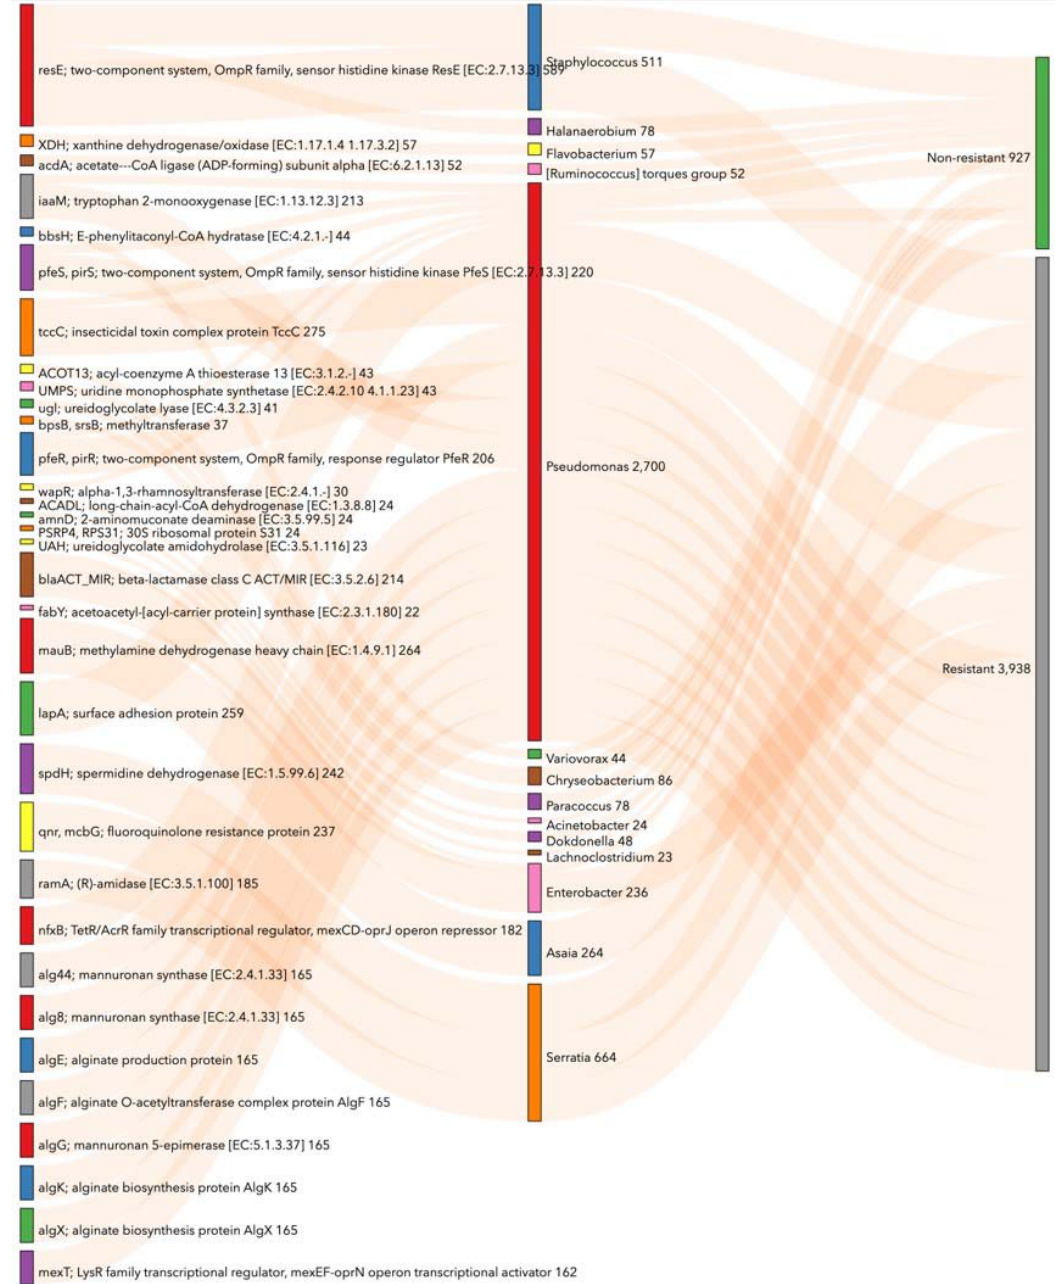
Figure 8. Enriched KEGG genes according to bacteria associated with Colombian Ae. aegypti midguts lambda–cyhalothrin resistance. This Sankey visualizes KEGG pathway groups’ significance ( p < 0.05) with ANCOM-BC analysis. The numerical value shows PICRUSt2 gene counts corresponding with taxonomy at the genus level. This chart shows the top 20 KEGGs per category by count. For an interactive view, visit https://observablehq.com/d/b3e7d8dd95cadd7a (accessed on 20 August 2022).